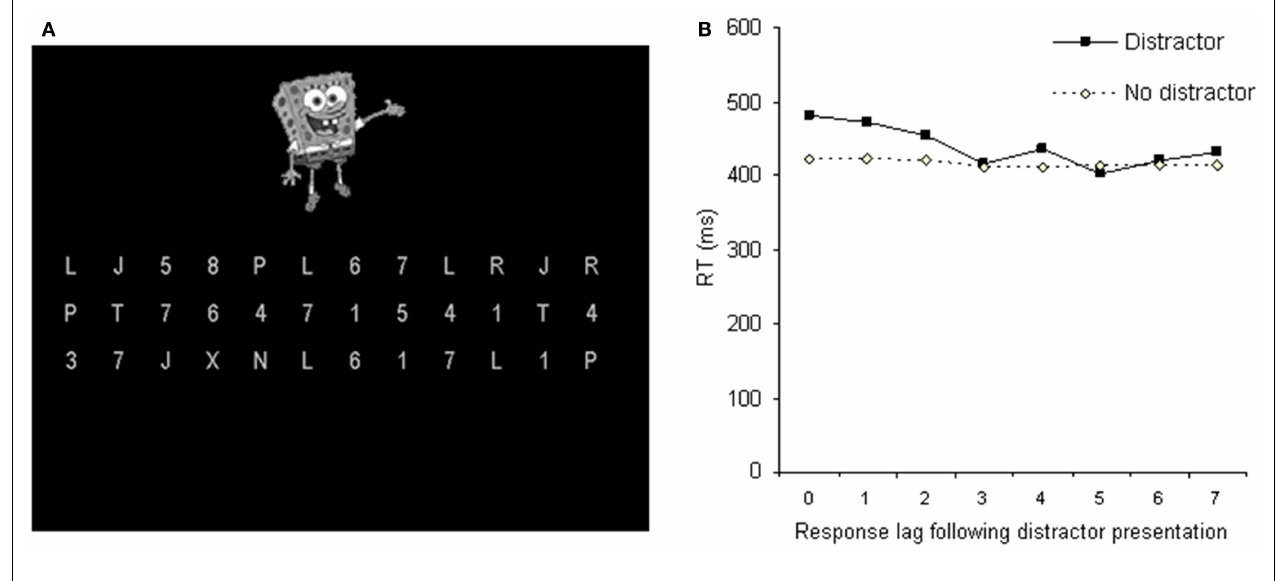
displays, and never co-occurs with the responses immediately following the display onset. (B) Despite being entirely irrelevant to the task in terms of visual appearance, meaning, location, and any attentional settings, the brief presentation of a distractor produces significant RT slowing for the response immediately following its presentation (lag 0), and for the two subsequent responses (lags 1 and